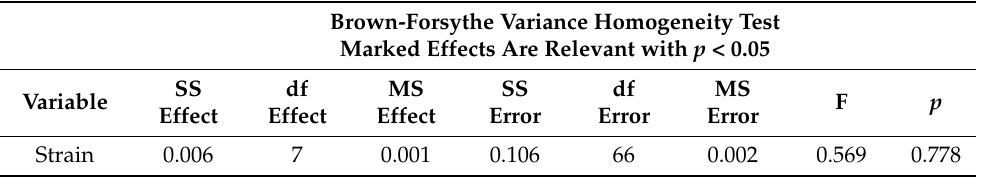
Table 1. Verification of the assumption of the homogeneity of variance by means of the Brown- Forsythe test with the reagent adopted as the grouping